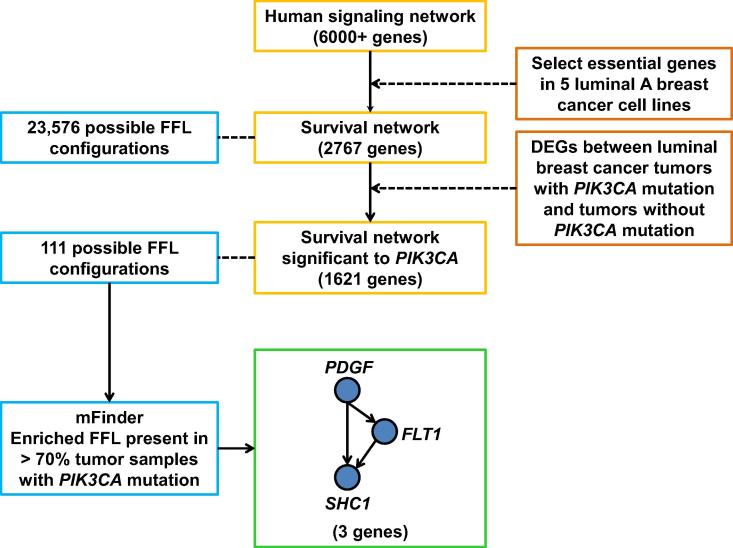
Workflow diagram to select the positive regulating FFLsIn the luminal A breast cancer survival network, there are 23,576 FFLs. Genes from the survival network were further stratified by selecting only those differentially expressed between luminal A tumors with mutation in PIK3CA and tumors without mutation in PIK3CA. The resulting network containing 1621 genes yielded 111 possible FFLs. To select FFLs important in PIK3CA-mutated tumors, we obtained the network propagation score values for each gene based on mutation status in each tumor and input these data into mFinder. One FFL pattern was found, of which gene interaction ratio was higher than average for each of the 3 nodes in the FFL and enriched in >70 tumor samples. FFL, feed forward loop; DEG, differentially-expressed gene.